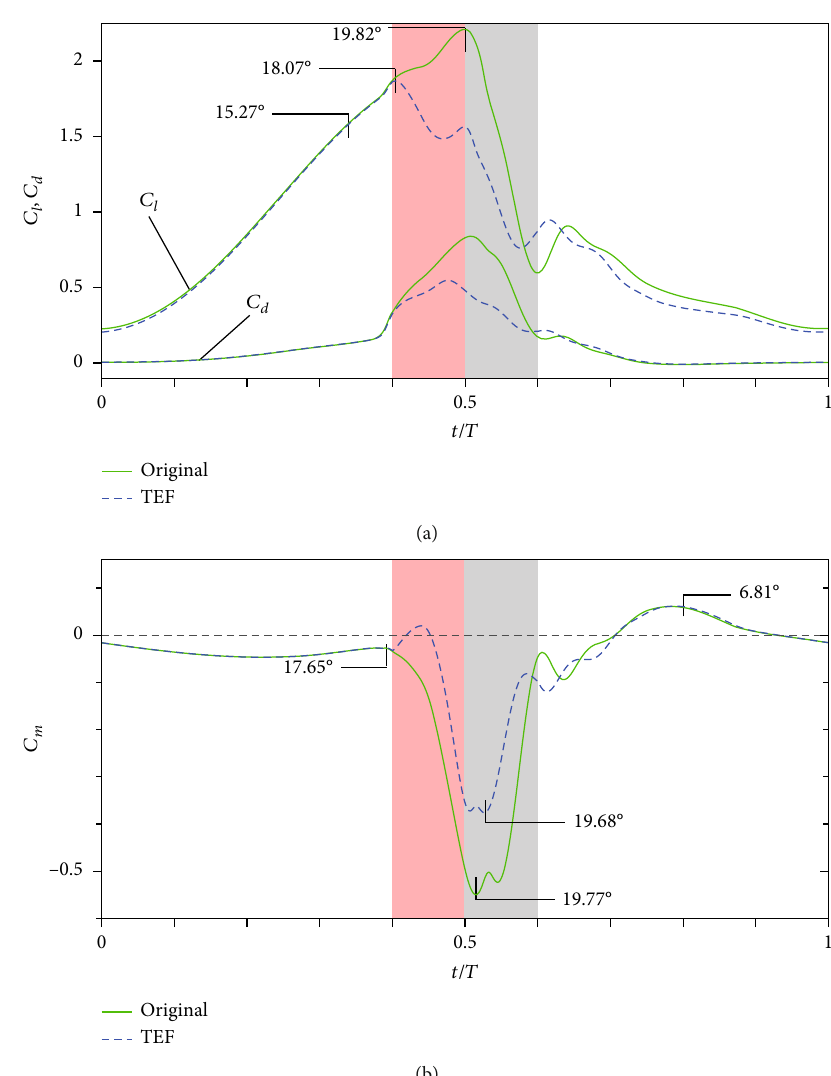
Figure 12: Comparison of aerodynamic force coe ffi cients between the original and TEF airfoils in the time domain: (a) lift and drag coe ffi cients and (b) pitching moment coe ffi cients. The pink region represents that the TEF de fl ects upwards. The gray region represents that the TEF de fl ects